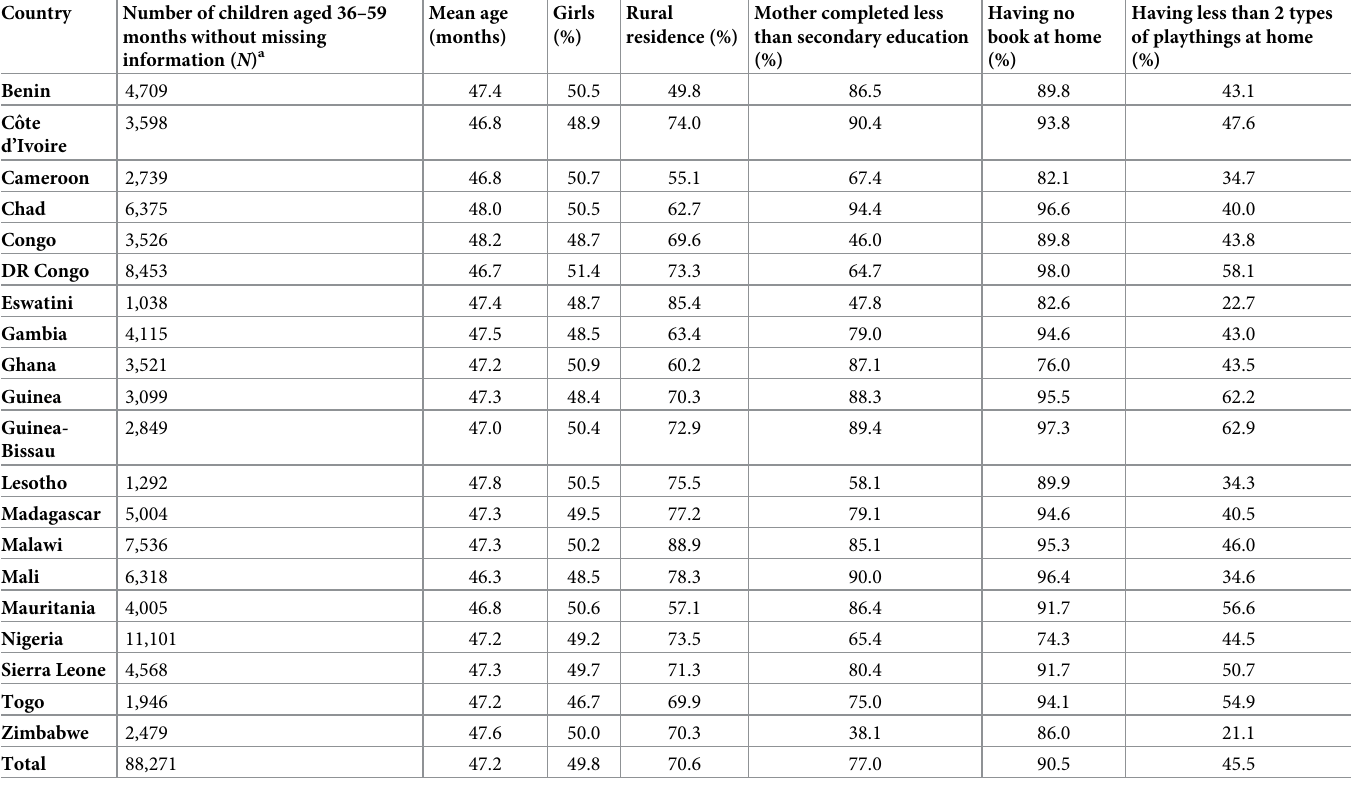
Table 2. Demographic characteristics of study